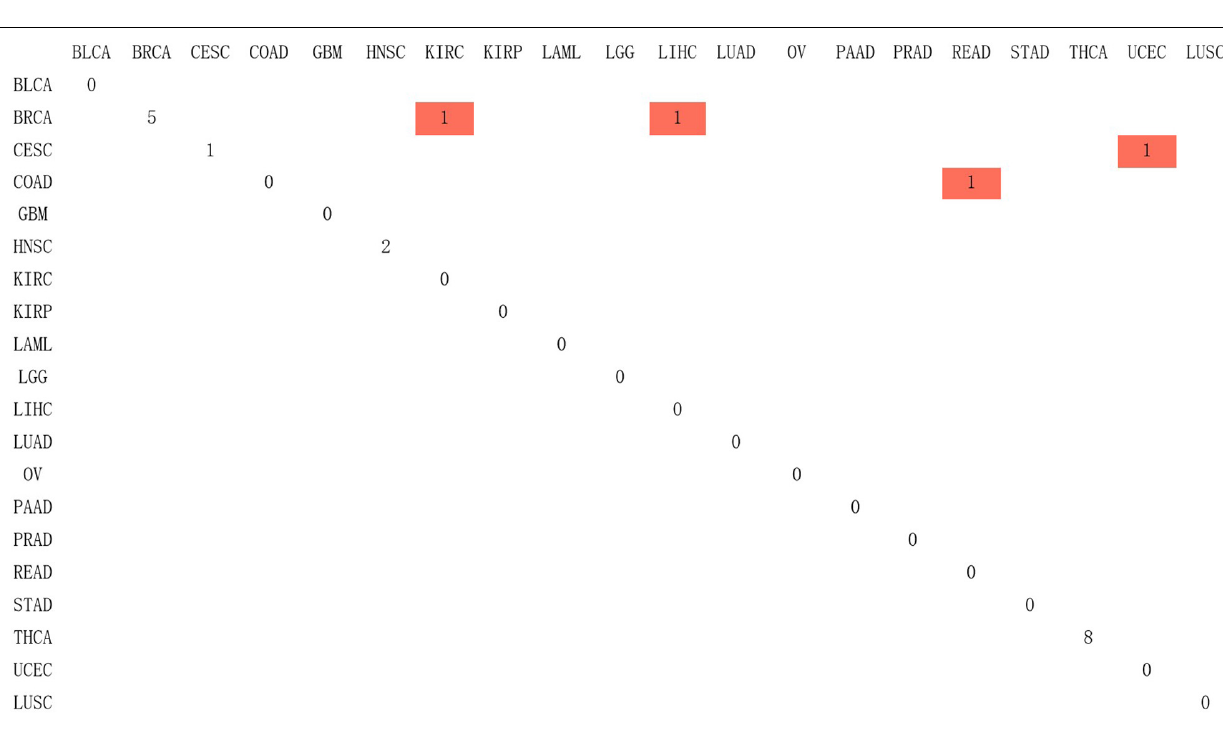
Frontiers in Bioengineering and Biotechnology | www.frontiersin.org